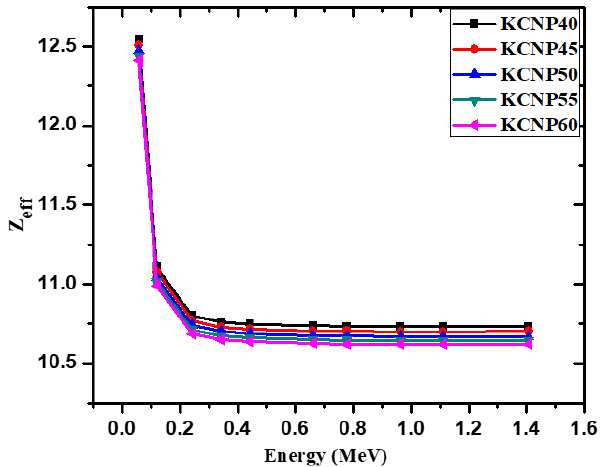
Figure 4. The effective atomic number for the fabricated glasses.